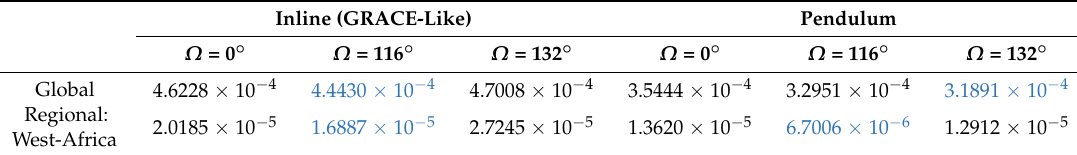
Table 5. Error RMS in terms of geoid height for global and regional (West-Africa) 6-day recovery up to L max = 64 of the scenario (a) inline and Pendulum formations. The smallest values in global and regional cases for each inline and Pendulum formation are written in blue.